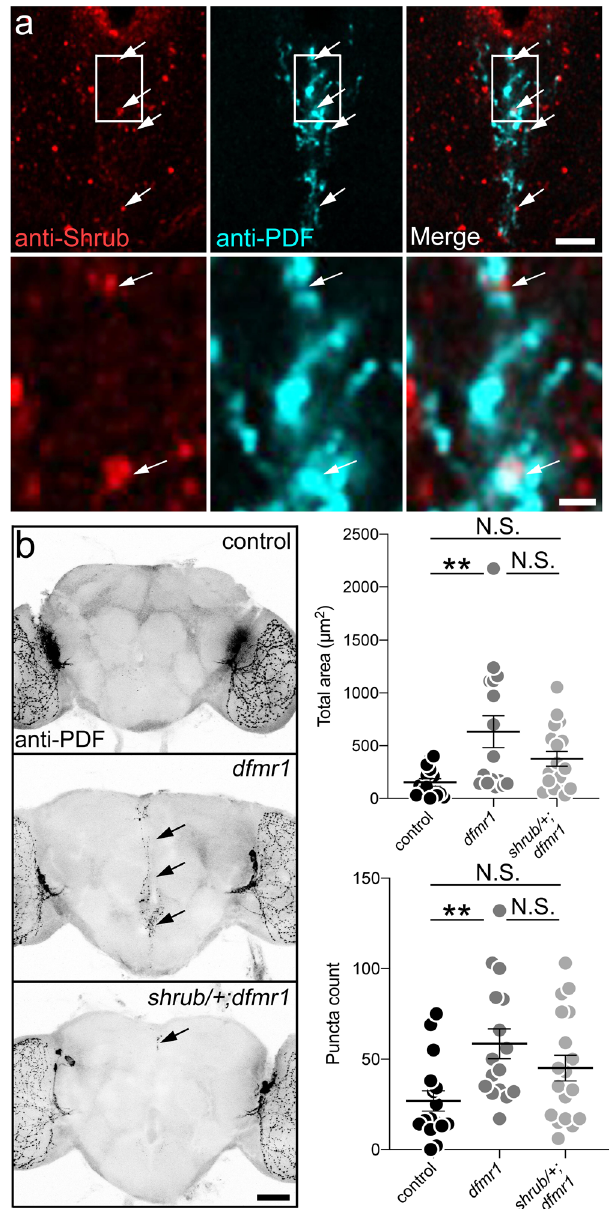
Neuron-to-glia insulin receptor (InR) signaling promotes glial phagocytosis of neurons, acting via Stat92e to elevate Draper levels during axotomy 42 . We show here that InR signaling med- iates developmental pruning, suggesting a broad role for InR signaling in neuronal clearance. Neurons secrete insulin-like peptides (Ilp) that activate glial InRs to induce Draper-1 42 . We discover here that InR signaling drives PDF-Tri neuron elim- ination, with glial InRs similarly activated during the critical developmental window (Figs. 8 and 9). We fi nd glial InR acti- vation reduced in the FXS model, consistent with known FMRP roles in insulin signaling 71 . We show neuronal FMRP drives glial InR activation to signal phagocytic clearance of PDF-Tri neurons, and that activating glial InR signaling in the FXS model restores neuronal clearance (Fig. 9). These fi ndings are consistent with previous work showing InR phosphorylation triggers glial pha- gocytosis 42 . This work shows a role for glial InR activation only in the clearance of injury-damaged neurons, whereas we fi nd glial InR signaling necessary for normal circuit remodeling within the